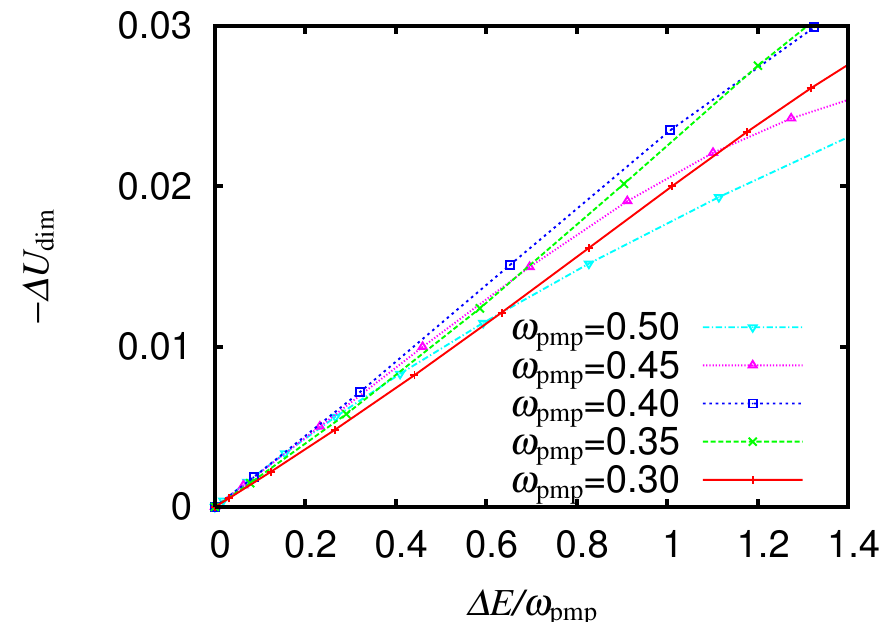
Figure 11. Modulation of effective on-site repulsion − ∆ U of absorbed photons ∆ E/ω from